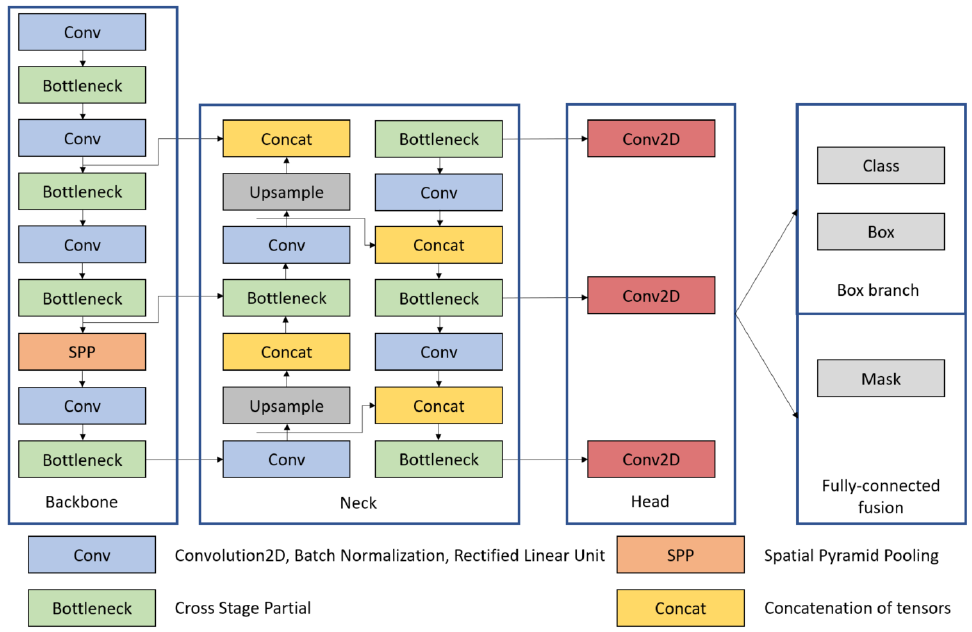
Figure 3. Outline of the YOLOv5 network architecture [12,13].